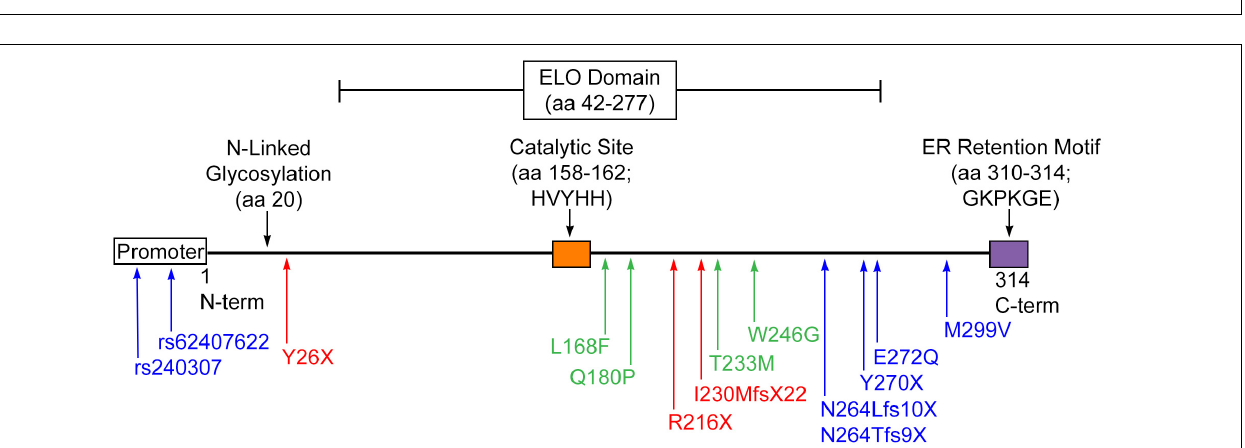
FIGURE 5 | Cell-specific expression of ELOVL4 in isocortex, hippocampus and cerebellum. (A–C) Cerebral Cortex (CTX). (A) Labeling for ELOVL4 is present in all layers of the cerebral cortex (CTX). Cells in the pyramidal layers (II/III and V) are most prominently labeled, but ELOVL4-positive cells also are present in the molecular layer (I), layer 4 (IV) and layer 6 (VI). (B) Labeling for the neuronal marker, NeuN. (C) Overlay of panels A and B shows close correspondence of ELOVL4 (red) and NeuN labeling (green). (D–F) Hippocampal formation (HPF). (D) Labeling for ELOVL4 is present in the cellular layers of the HPF, including the Cornu Ammonis, with field 1 (CA1) showing less prominent labeling than field 3 (CA3). Prominent ELOVL4 labeling also is present in the subiculum (sub) and interneurons in the polymorph layer (arrow). Cells along the inner margin of the dentate gyrus (DG) show moderate ELOVL4 labeling, but most dentate granule cells show little ELOVL4 labeling. (E) Labeling for the neuronal marker, NeuN. (F). Overlay of (D,E) shows close correspondence of ELOVL4 (red) and NeuN (green) labeling. TH, Thalamus. (G–I) Cerebellar cortex. (G) Cross section through a cerebellar folium showing ELOVL4 expression in the cerebellar cortex. Neurons (arrows) in the molecular cell layer (mcl) show strong ELOVL4 labeling, but the Purkinje cells (arrowheads) in the Purkinje cell layer (pcl) show only moderate levels of ELOVL4 labeling. The densely packed cells of the granule cell layer (gcl) show very intense labeling. (H) Labeling for the neuronal marker, NeuN, strongly labels neurons in the gcl, but not Purkinje cells, as appropriate. (I) Overlay of (G,H) shows close correspondence of intense ELOVL4 (red) and NeuN (green) labeling resulting in an orange color in the gcl. wm, white matter of the arbor vitae. Scale bars = 200 µ m for (A–C,G–I) ; 500 µ m for (D–F) (figure from Sherry et al., 2017; used with open access under the Creative